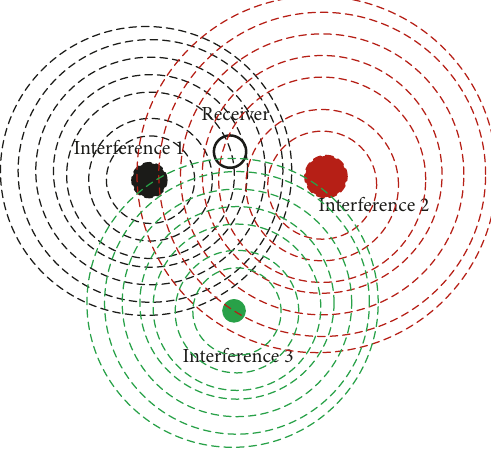
Figure 2: The multiple user interference